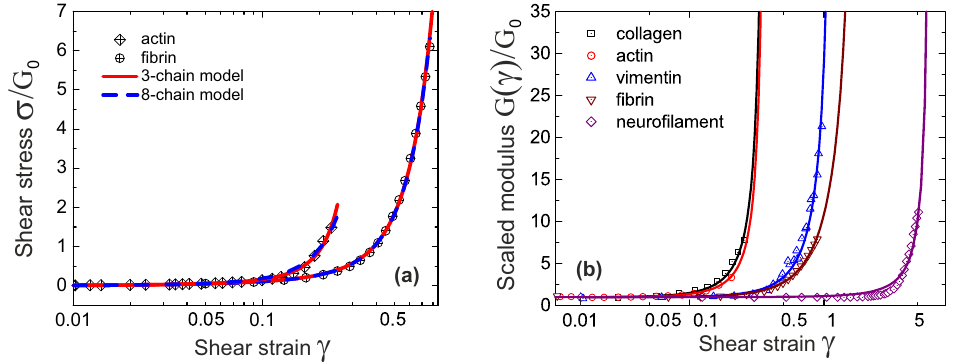
Figure 8. ( a ) Shear stress-strain relation fitted by 3-chain and 8-chain model (data from Ref. [29,41]); ( b ) Fitting modulus-strain data from Ref. [29] of sheared collagen, actin, vimentin, fibrin and neurofilament.